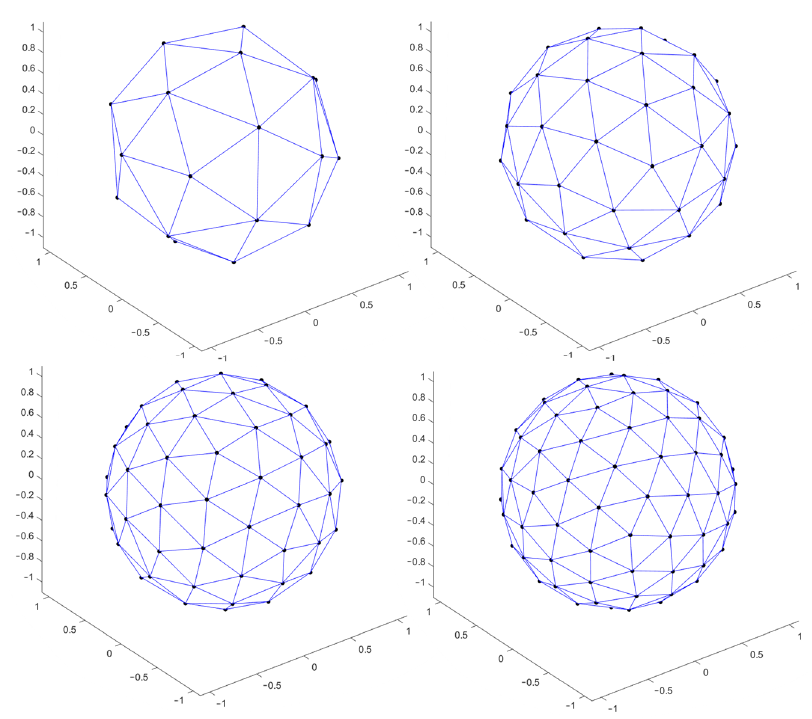
Figure 1. Calculated point distribution on the surface of a sphere ( top left ) 25 points, ( top right ) 50 points, ( bottom left ) 75 points, ( bottom right ) 100